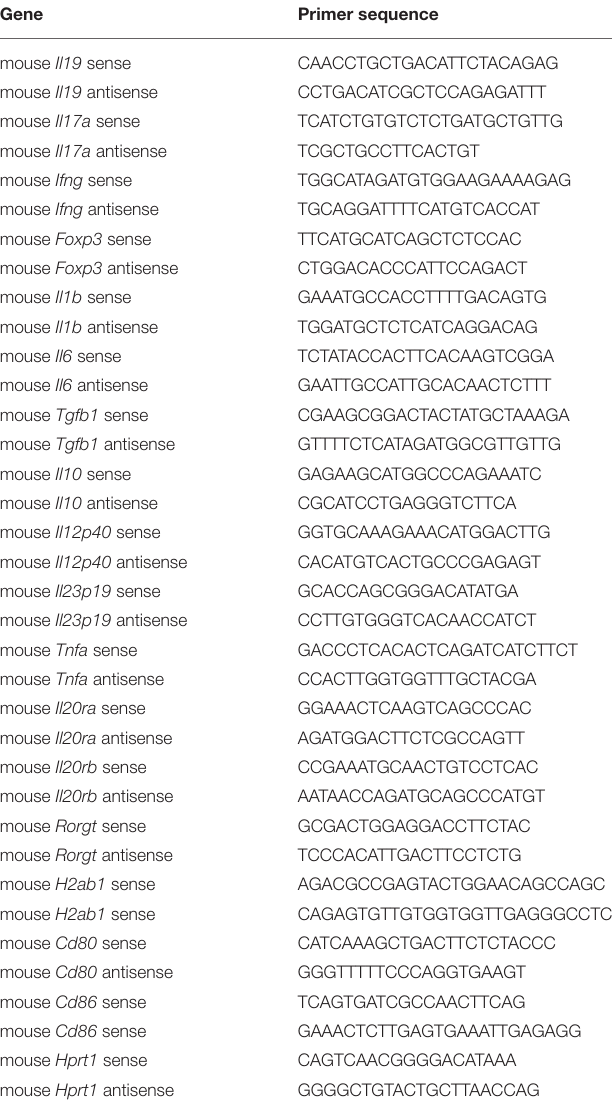
TABLE 1 | Primers for